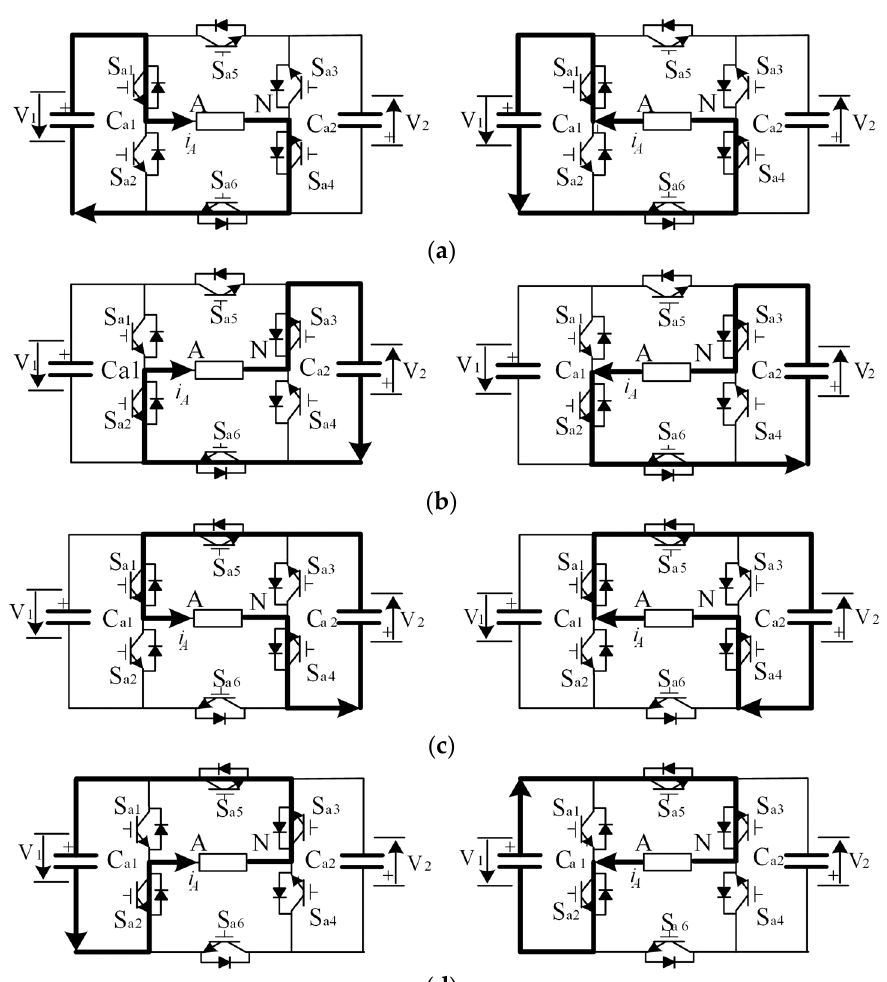
Figure 4. Circuit state during C a 1 , C a 2 charge and discharge: ( a ) Level 6; i A > 0, i A < 0; ( b ) Level 5; i A > 0,